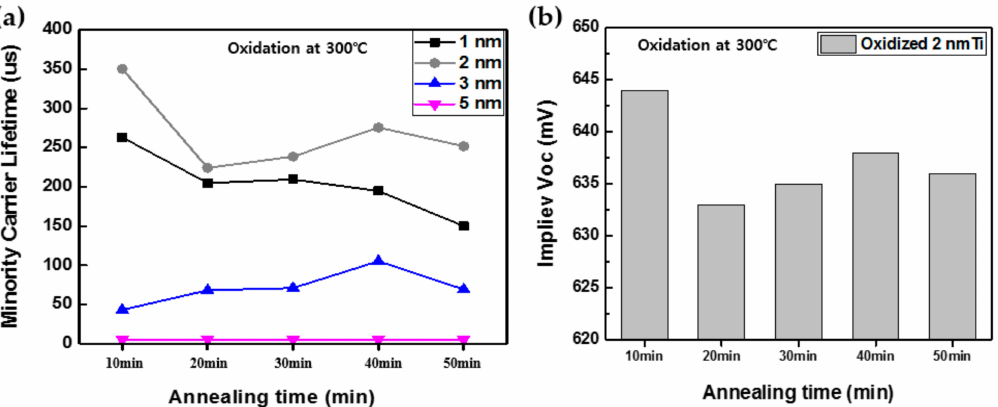
Figure 5. ( a ) minority carrier lifetime according to thickness of metal layer; ( b ) implied V oc of oxidized 2 nm titanium.